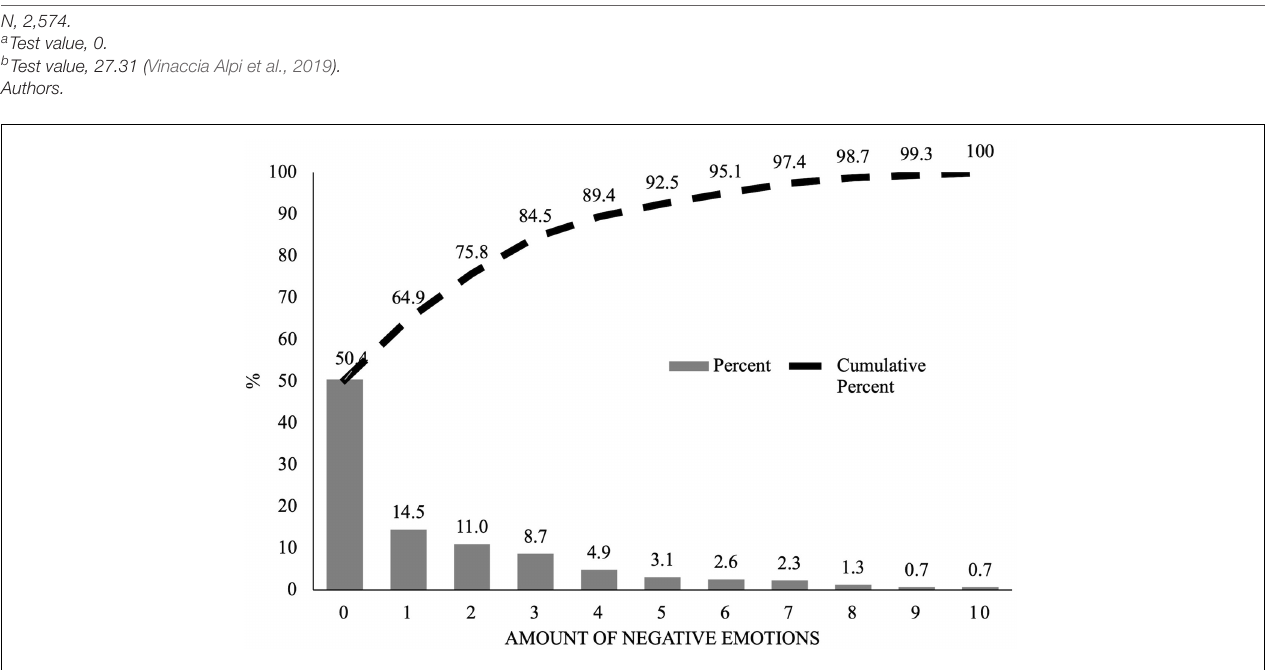
FIGURE 1 | Distribution of negative